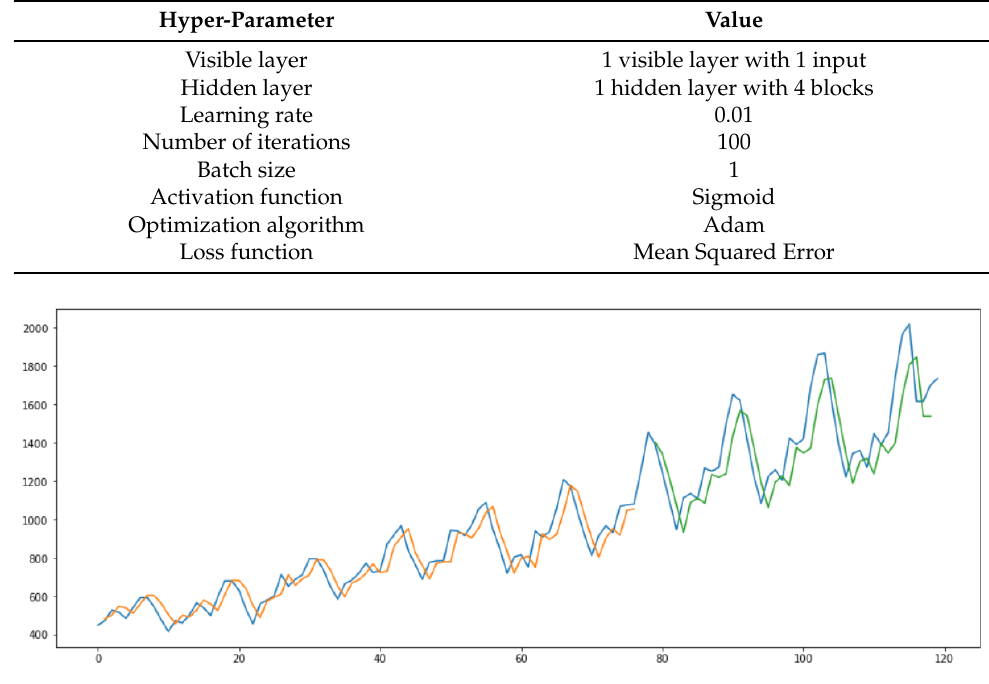
Figure 4. Forecasted future demand using LSTM.